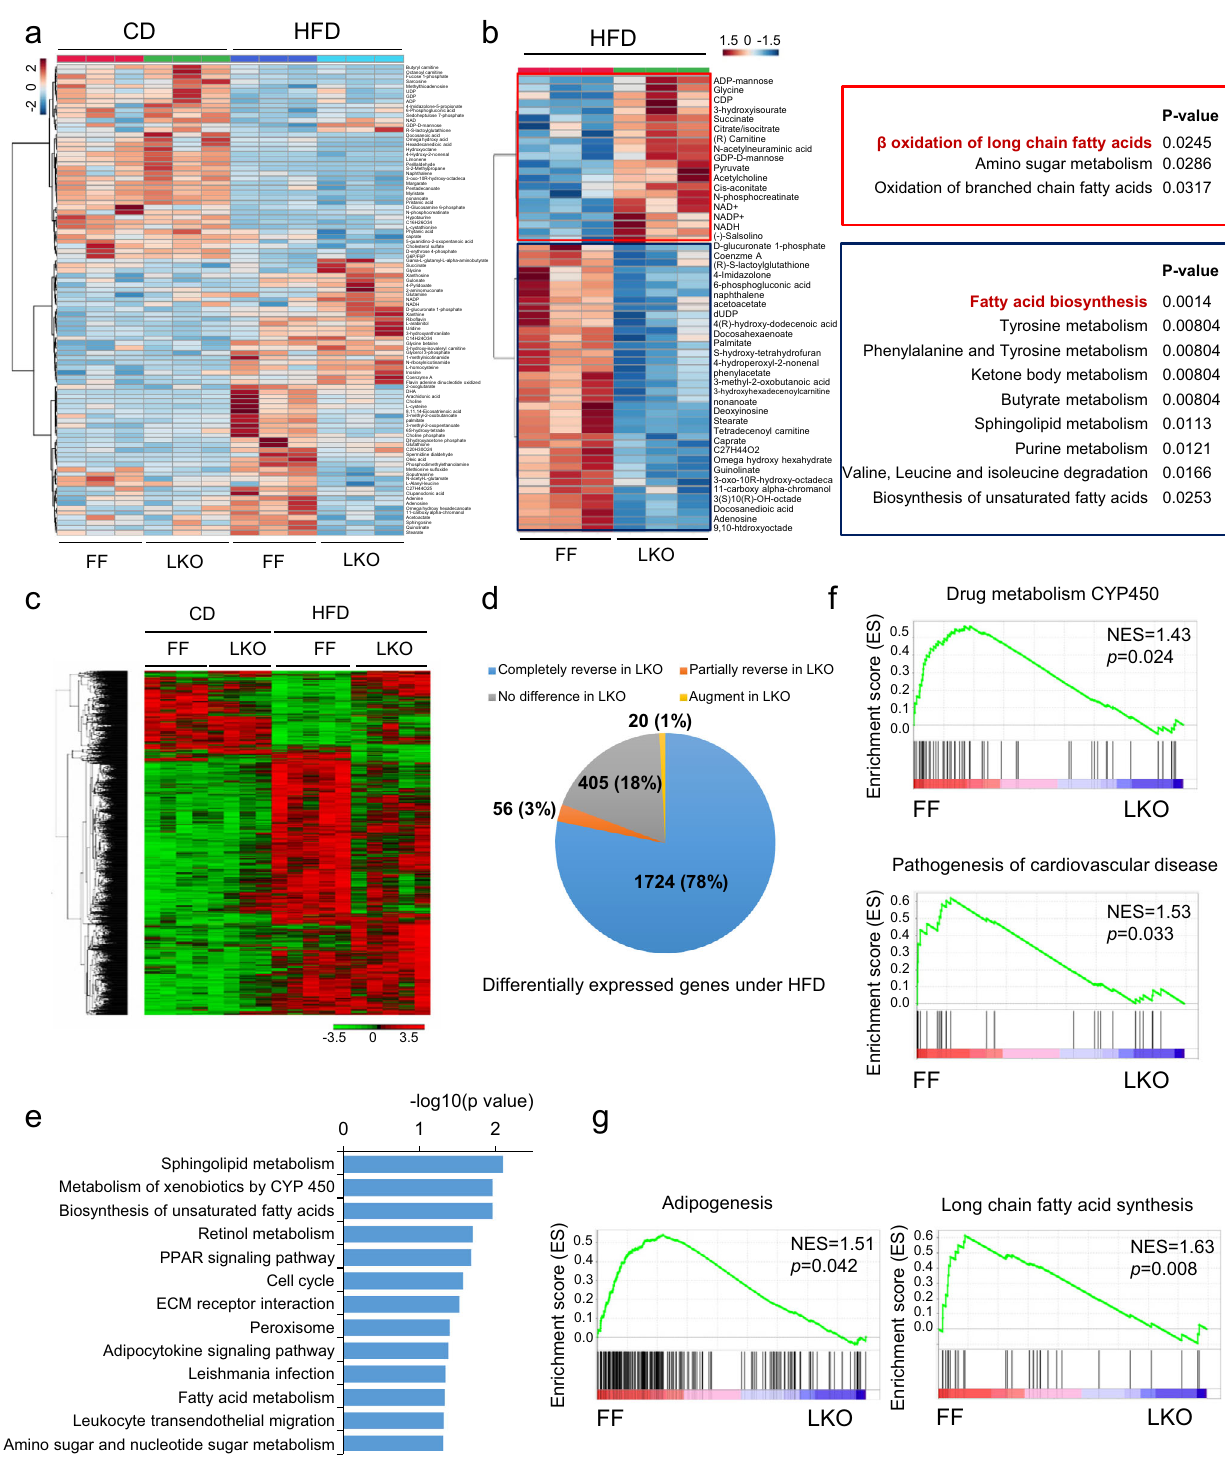
Fig. 4 | Loss of SAPS3 reverses metabolic and transcriptional alterations induced by HFD. a Heatmap of signi fi cantly changed metabolites in liver samples from FF and LKO mice fed with different diets was analyzed by LC-MS. n =3 mice per group analyzed by one-way ANOVA. b Pathway analysis of upregulated meta- bolites and downregulated metabolites from FF and LKO mice respectively. n =3 mice per group analyzed by unpaired t -test. c Transcriptional pro fi le heatmap denoting signi fi cantly changed genes in liver samples from FF and LKO mice fed with different diets. CD n =4 mice per group; HFD, n =5 per group. Fold change >